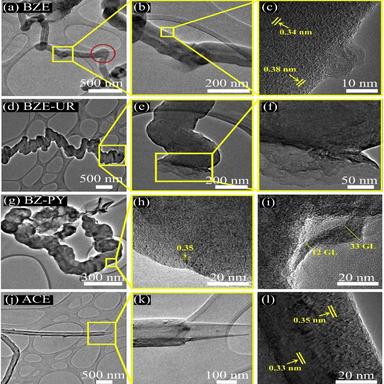
TEM images of N-doped carbon sponges. (aec) Wavy and rough carbon fiber from the sample BZE, (def) carbon fiber with a zigzagging behavior from the sample BZE-UR, (gei) carbon fiber with an irregular growth from the sample BZ-PY, and (jel) coaxial carbon fibers from the sample ACE. TEM, transmission electron microscopy; BZ-PY, pyridinebenzylamine; ACE, acetonitrile-ethanol; BZE-UR, BZE saturated with urea; BZE, benzylamine-ethanol.